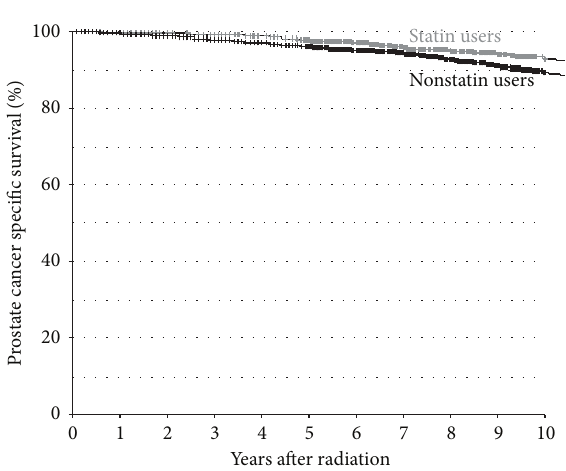
Table 2: Prostate cancer survival.